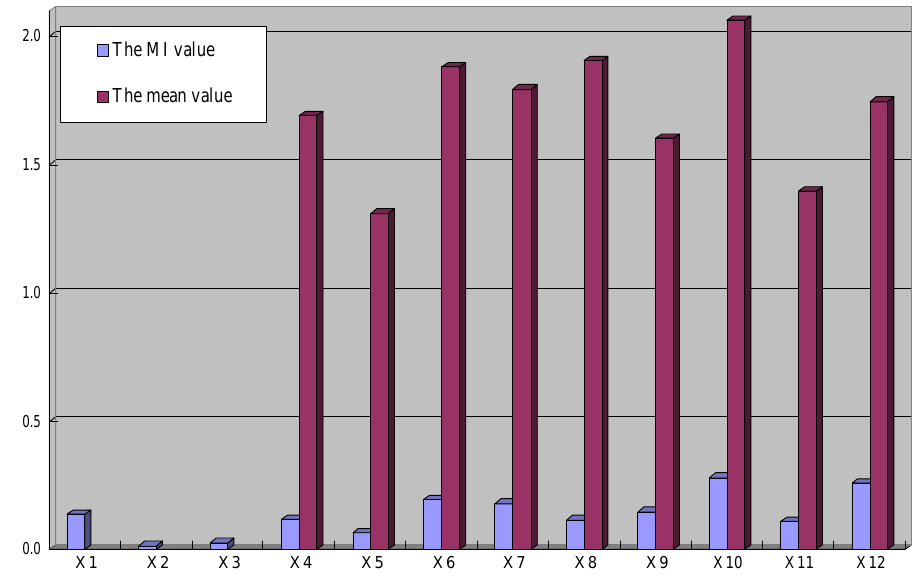
Figure 2. The MI and mean values of each deciding factor for all